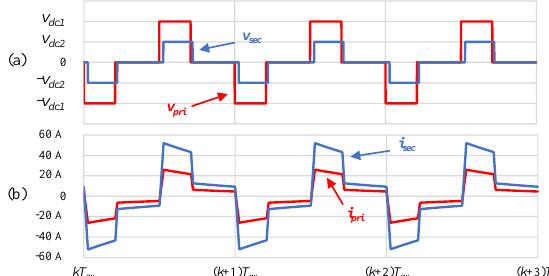
Figure 18. Waveforms in the primary and secondary sides of the HF transformer when the DAB operates under TPS modulation: (a) Voltage; (b) Current.